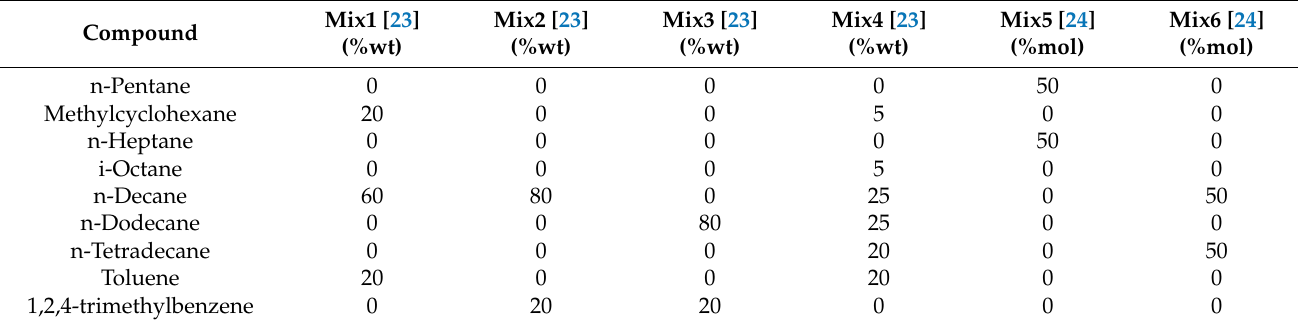
Table 2. Composition of the six validation mixtures from